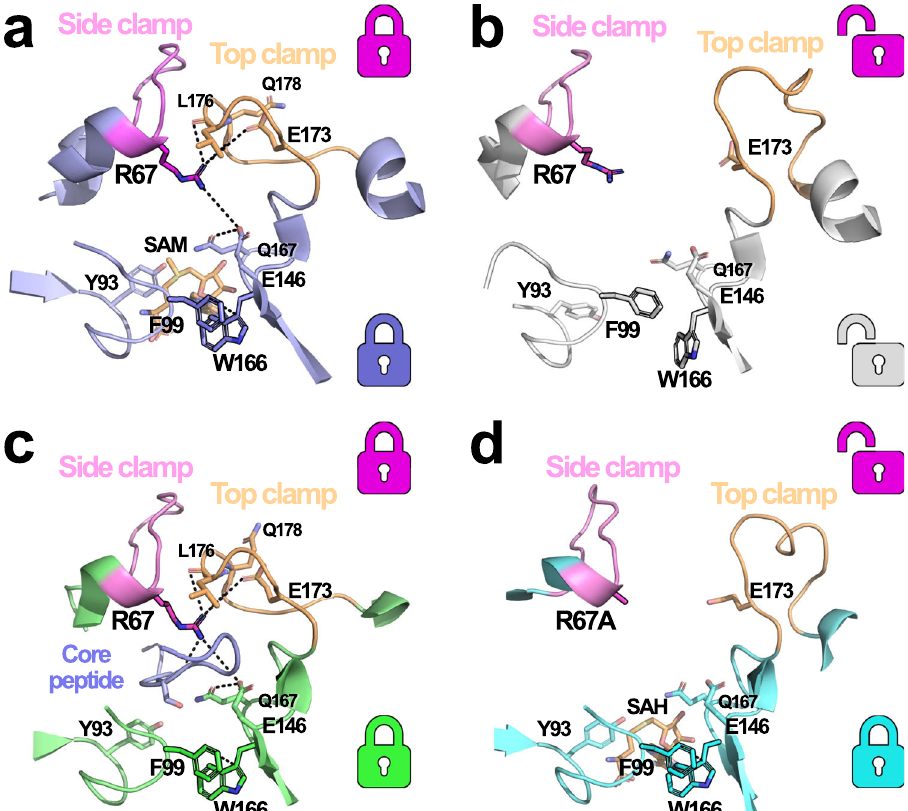
Fig. 6 Interaction networks enabling multiple conformational states. a The closed conformation in the SonM — SonA-BBD — (±)SAM complex with SAM (orange sticks) bound in the active site. The hydrogen-bonding network involving SonM-R67 closes the top lock in the active site, while the π -stacking of SonM-F99 and SonM-W166 forms the bottom lock. b The open conformation in the SonM — SonA-BBD — (±)SAM complex without SAM reveals open top and bottom locks. c The apo SonM — SonA-2Me complex reveals both the top and bottom locks closed, using a similar network of interactions seen in a but with the core peptide present and cofactor absent. d The SonM-R67A — SonA-0Me — SAH complex is unable to form the top lock due to mutation of SonM- R67 but maintains the bottom lock contacts through binding of SAH. The core peptide in the active site of this complex was removed in this image for clarity. Key hydrogen bonds and distances are depicted as black dashed lines. Top and bottom locks are illustrated with corresponding color-coded icons next to each